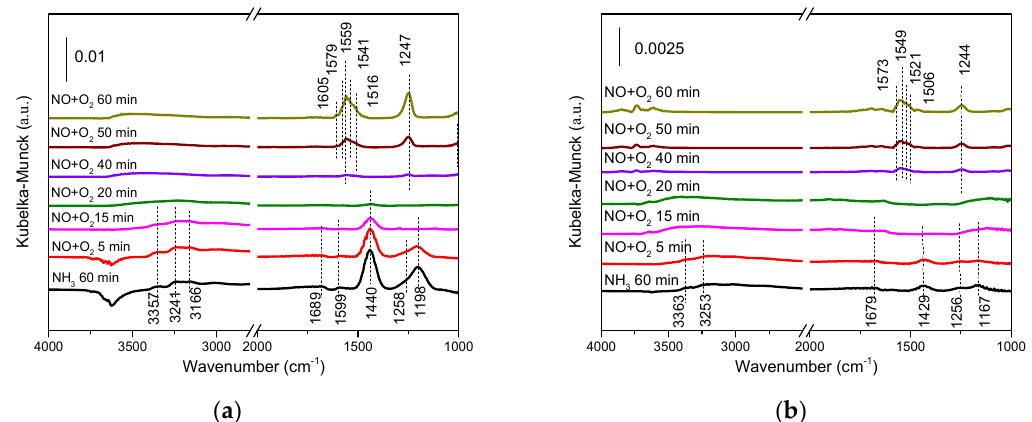
Figure 9. The in situ DRIFT of NO + O 2 reacting with preadsorbed NH 3 species over ( a ) the SbCeZr and ( b ) the SbCe catalysts at 200 °C.